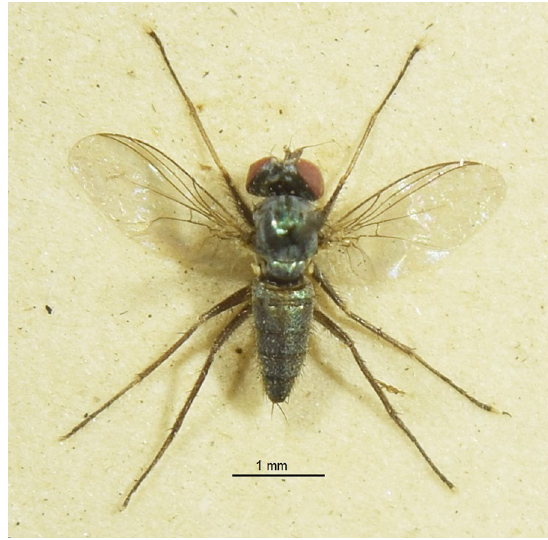
Fig. 2 Asyndetus albifrons Parent male habitus,